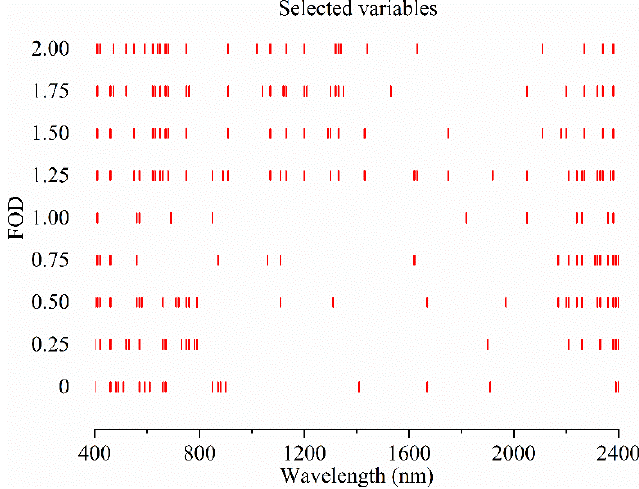
Figure 8. The distributions of spectral variables selected by elastic net (ENET) method at different derivative orders.